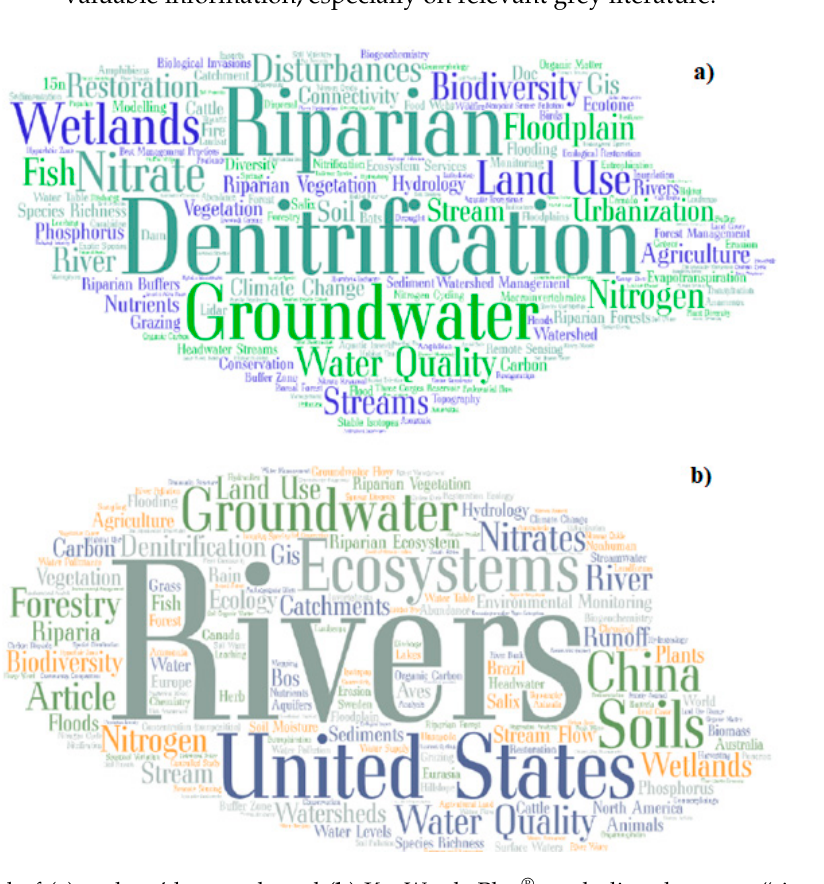
® , excluding the terms “riparian zone(s)” and